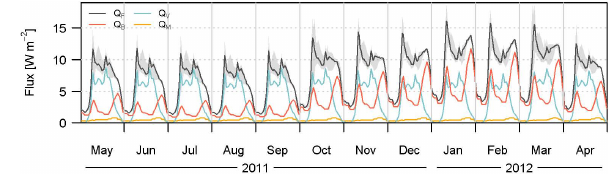
Fig. 6. Mean diurnal cycles of building energy use ( Q B ), vehicle emission ( Q V ) and human metabolism ( Q M ) contributions to total anthropogenic heat flux ( Q F ) for the study period (see Appendix A for details). Shading indicates maximum and minimum Q F